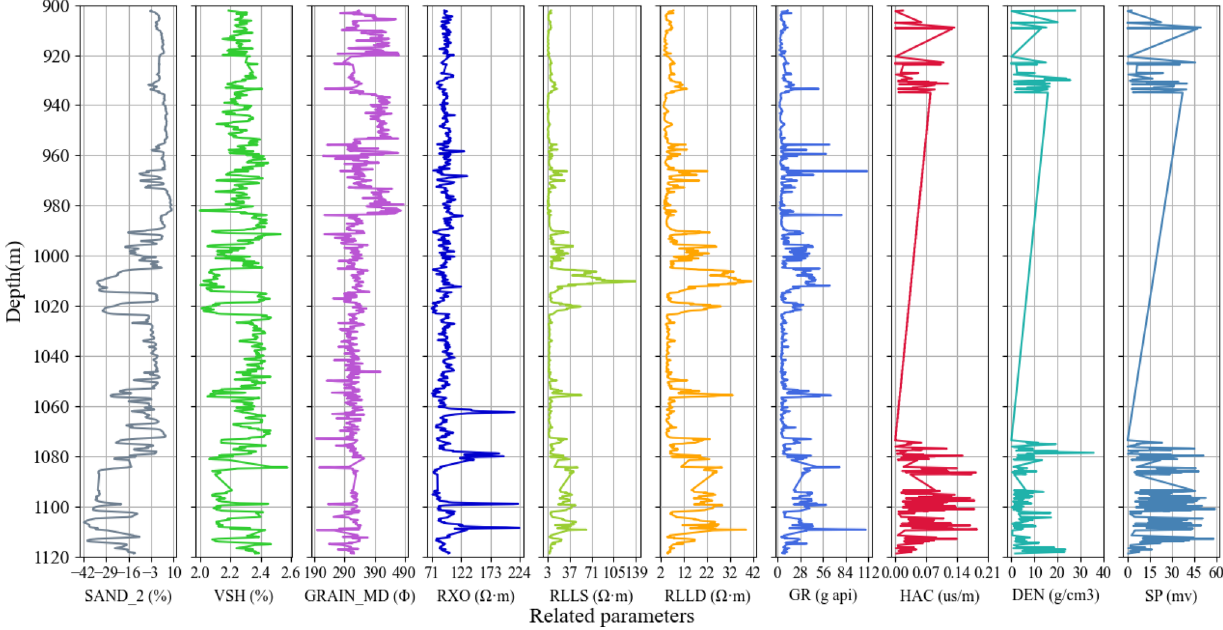
Fig. 5 Numerical distribution of the logging